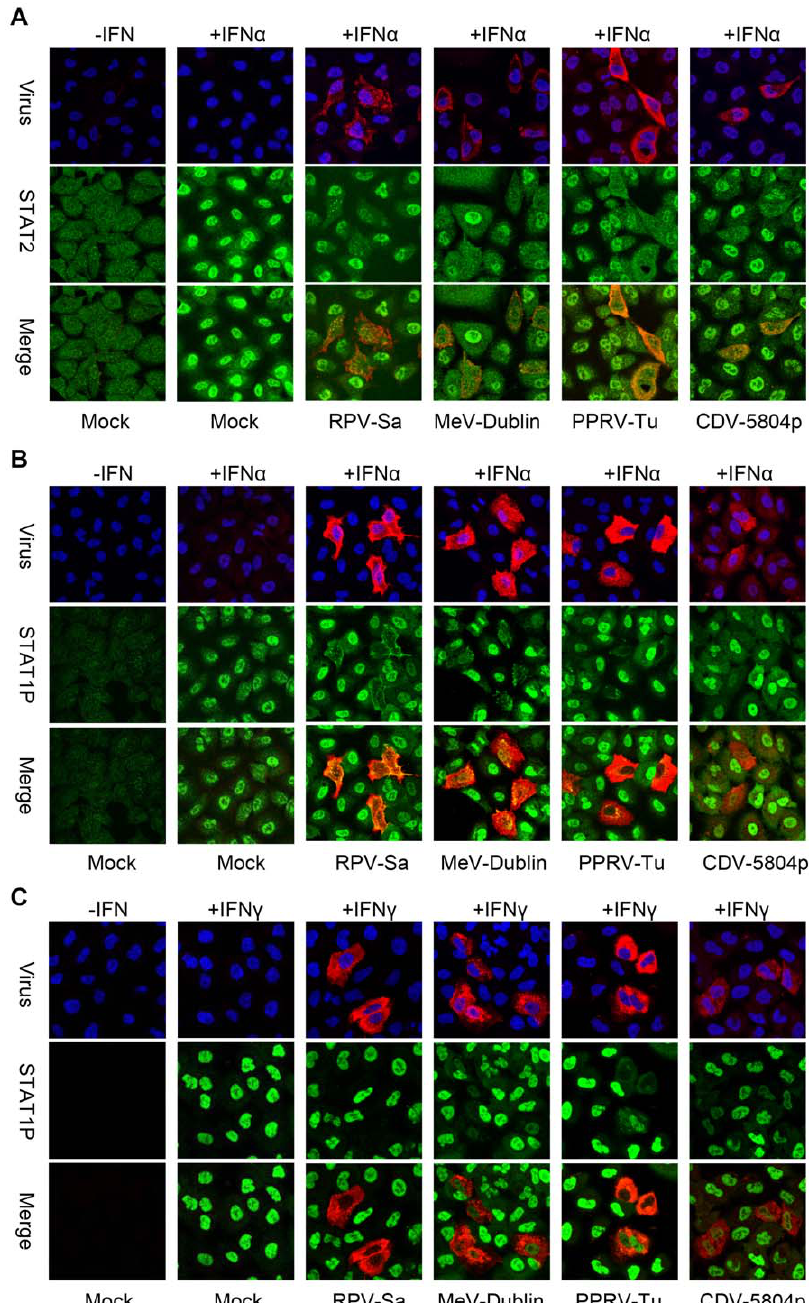
Figure 1. All four morbilliviruses efficiently blocks IFN a -induced STAT2 phosphorylation, but show varied abilities to block IFN a and INF- c induced STAT1 phosphorylation. A549 cells were mock infected or infected with the indicated morbillivirus as in ‘‘Material and methods’’. Eighteen hours post-infection cells were mock treated or treated with 1000 IU/ml of IFN a (a), (b) or 1000 IU/ml of IFN c (c) for 30 minutes, fixed with PFA and methanol and stained with (a) rabbit anti-STAT2 plus goat anti-PPRV or (b, c) mouse anti-phospho-STAT1 (STAT1P) plus rabbit anti-RPV. Representative confocal images from three independent experiments are shown.